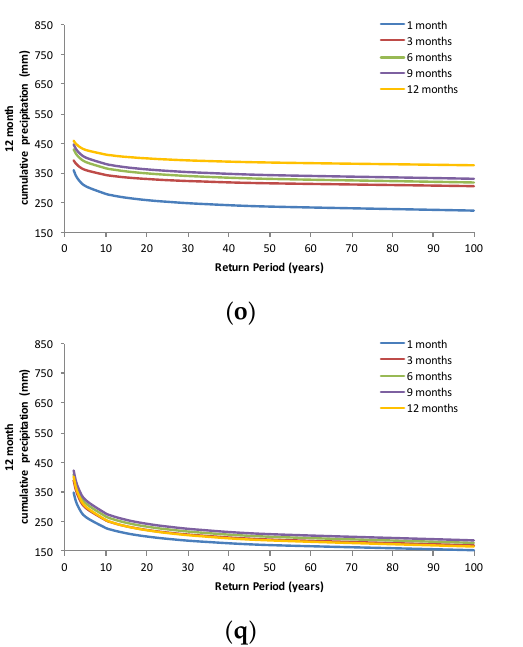
Figure 6. Severity-Duration-Frequency curves for the stations: ( a ) São Francisco; ( b ) São João da Ponte; ( c ) Janaúba; ( d ) Manga; ( e ) São Gonçalo; ( f ) Cajueiro; ( g ) Itamarati; ( h ) São João do Paraíso; ( i ) Rio Pardo de Minas; ( j ) Vila Terra Branca; ( k ) Arinos Montante; ( l ) Vila Urucuia; ( m ) São Romão; ( n ) São João da Vereda; ( o ) Urandi; ( p ) Inhobim; ( q ) Itaobim. For a general approach in the semi-arid climate area contained in Minas Gerais, regionalized SDF curves were plotted. The adopted method for the regionalization was using a weighted average among the individual station results through the Thiessen polygons method. Considering the influenced area of each one of the stations, the weighted average of the 12-month cumulative precipitation for the semi-arid region in Minas Gerais was calculated and can be visualized in the regionalized SDF curves plotted in Figure 7.